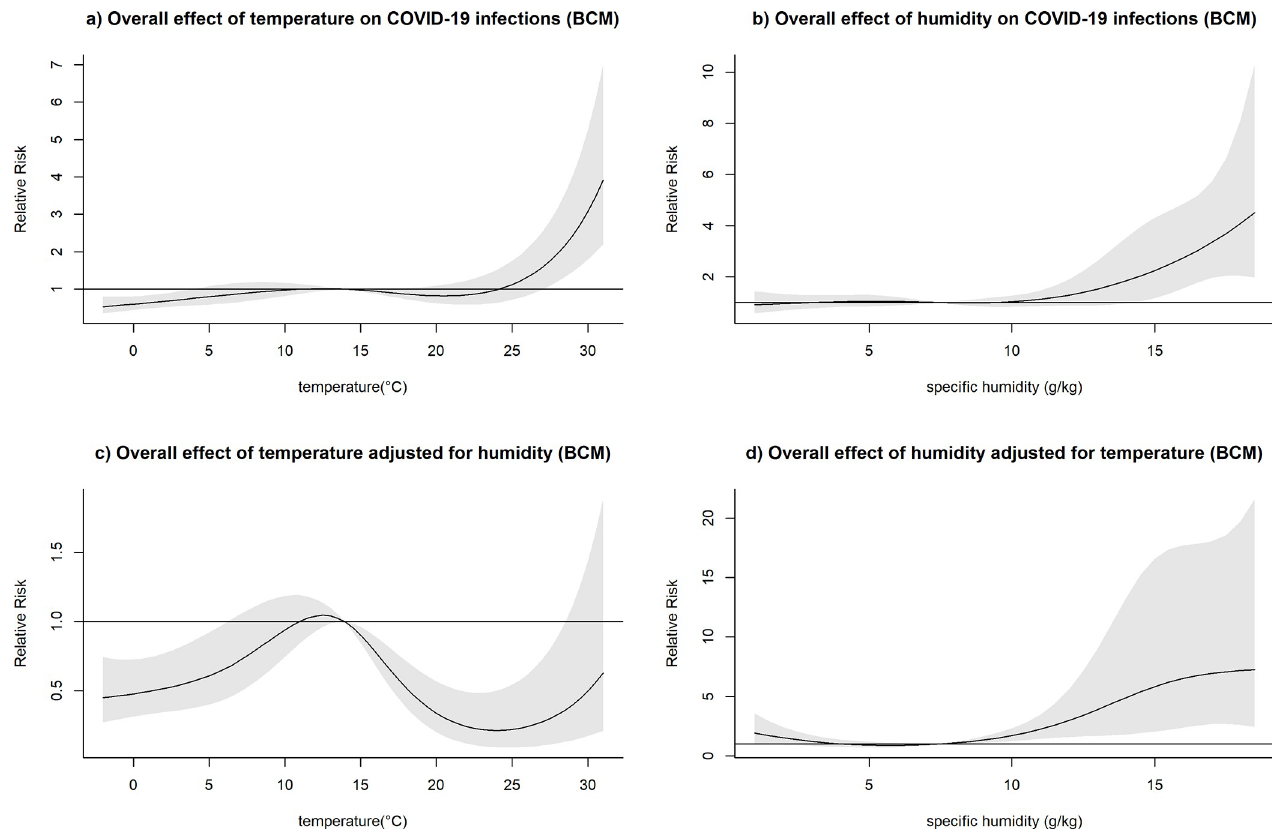
Fig 5. Overall effect of temperature and humidity on COVID-19 infections in Baltimore and Baltimore County, Maryland (BCM). The relative risk of COVID-19 infection was plotted across the range of temperature/humidity to show the a) Unadjusted effect of temperature; b) Unadjusted effect of humidity; c) Effect of temperature adjusted for humidity; d) Effect of humidity adjusted for